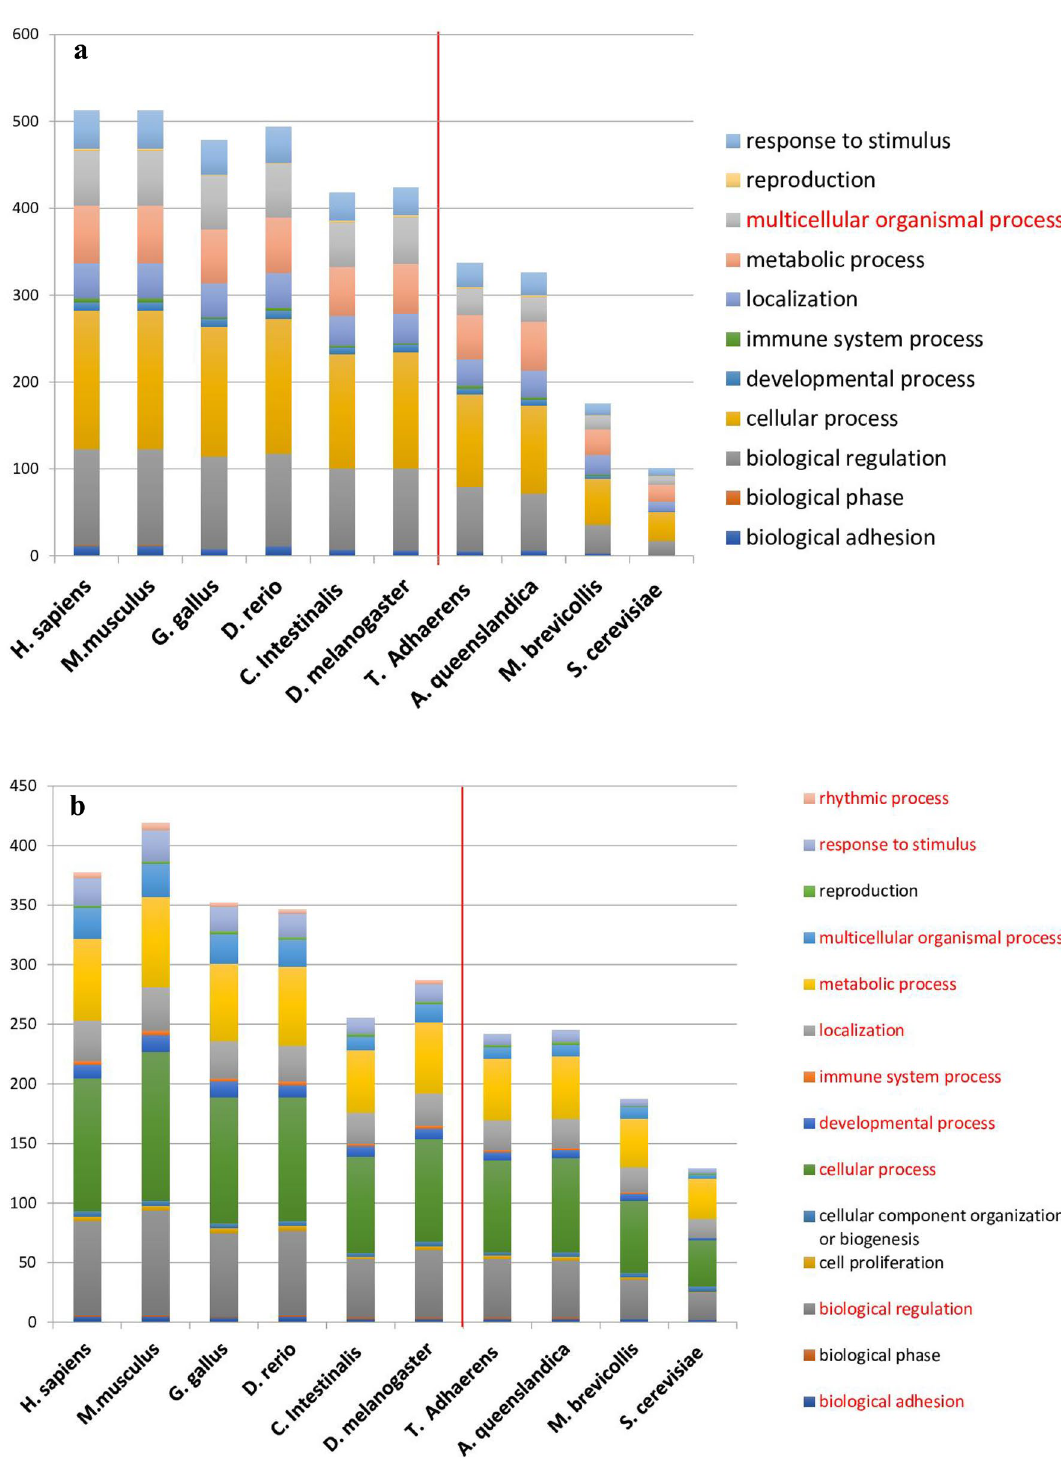
Figure 3. Functional classifications of the orthologs of memory and LMNP proteins. ( a ) Functional groups comparison of memory-related proteins between memory-posses species and memory-lacking species. ( b ) Functional groups comparison of LMNP proteins between LTM- possess species and LTM-lacking species. The red color shows significant categories ( p < 0.05), and the red line is drawn to divide the two groups